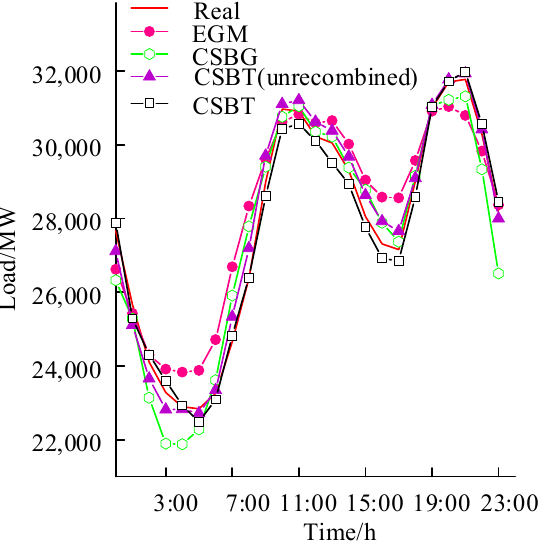
Figure 6. The forecasting results of the CBST model, EGM, CSBG, and CSBT (unrecombined) mod-